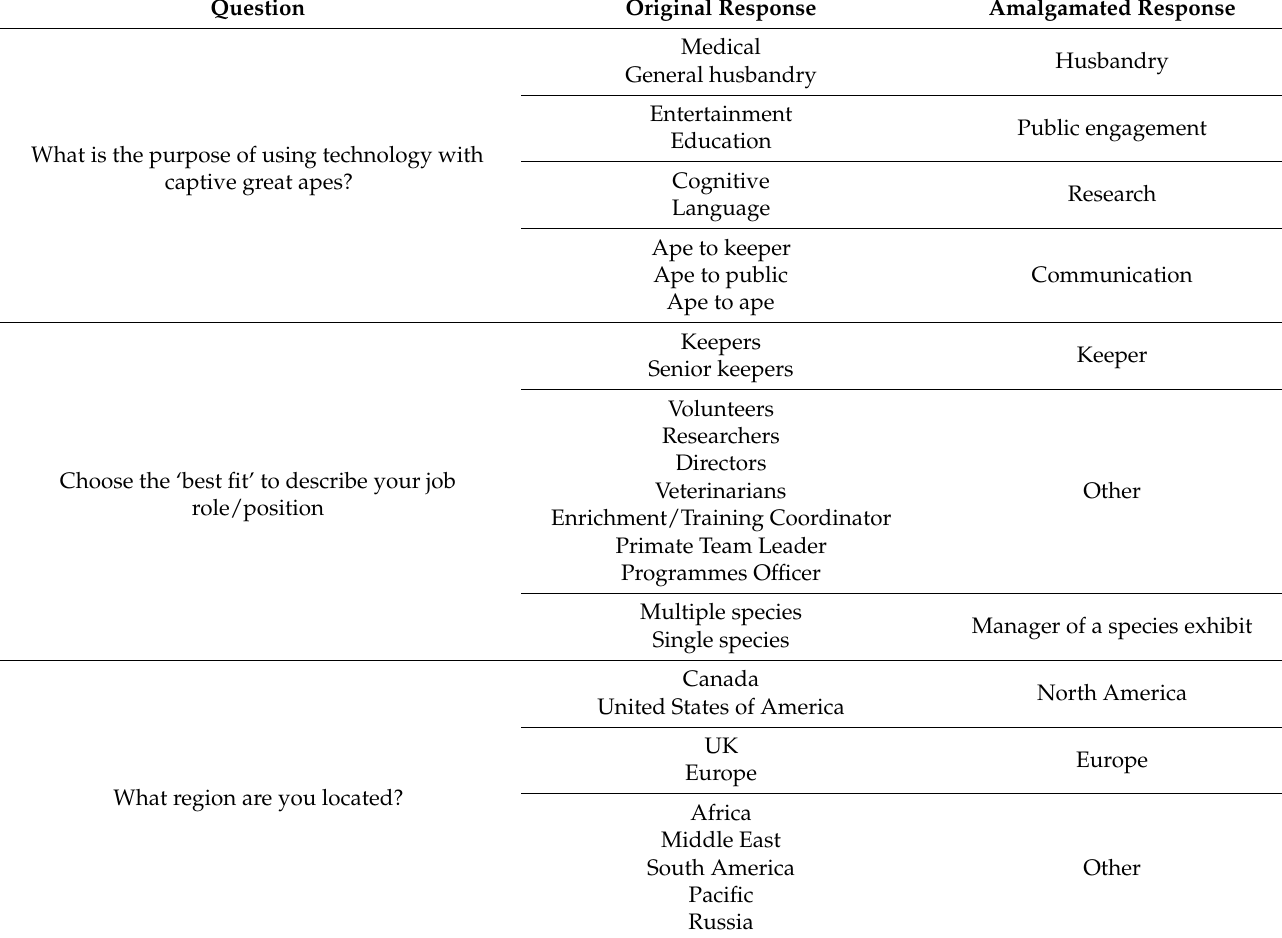
Table 1. The original responses to survey questions that were amalgamated for the purpose of data analyses. Question